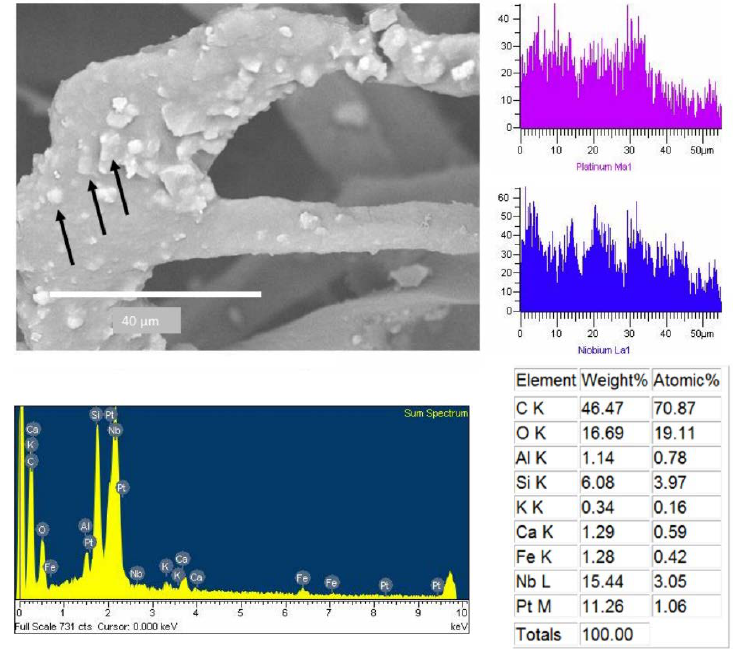
Figure 10. Metallic particle that contains platinum was found on CAF (black arrows).